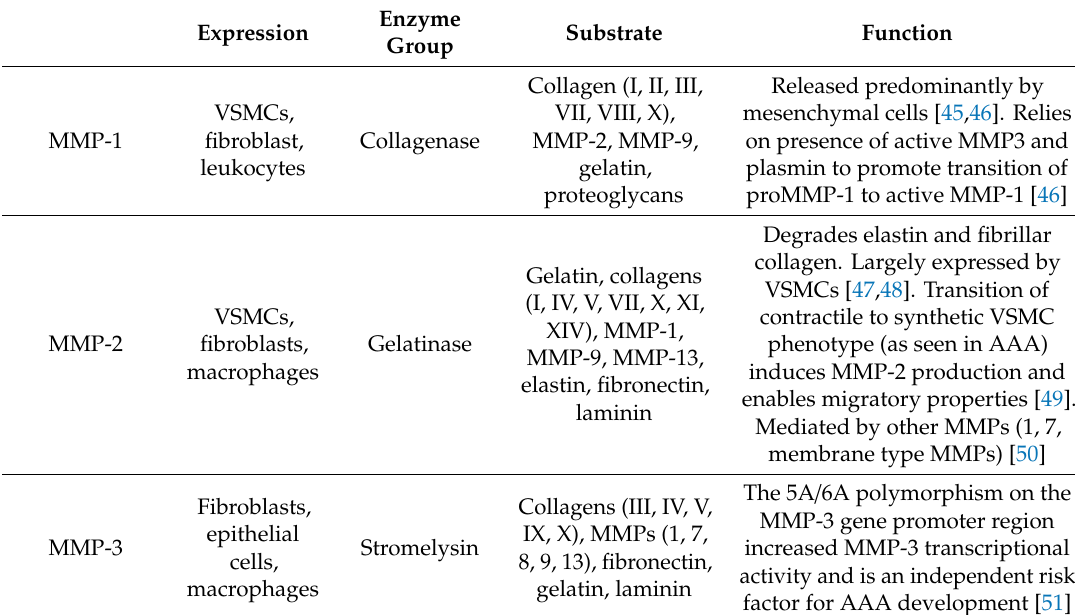
Figure 1. Schematic of the abdominal aortic aneurysm (AAA) aorta and vascular cells involved in the degradation of the extracellular matrix (ECM). Vascular smooth muscle cells (VSMCs), endothelial cells (EC), and macrophages (M Φ ) release cytokines that elevate inflammation in AAA and promote VSMC proliferation as well as apoptosis. VSMCs, macrophages, and fibroblasts also contribute to the elevation of matrix metallopeptidases (MMPs), which lead to ECM degradation. miR-712 targets tissue inhibitor of metallopeptidase (TIMP)3 to further promote ECM degradation in AAA. Downregulation of miR-24 and miR-143 lead to increased inflammation. Table 1. Key MMPs that are synthesized by VSMCs and / or mediate ECM degradation in